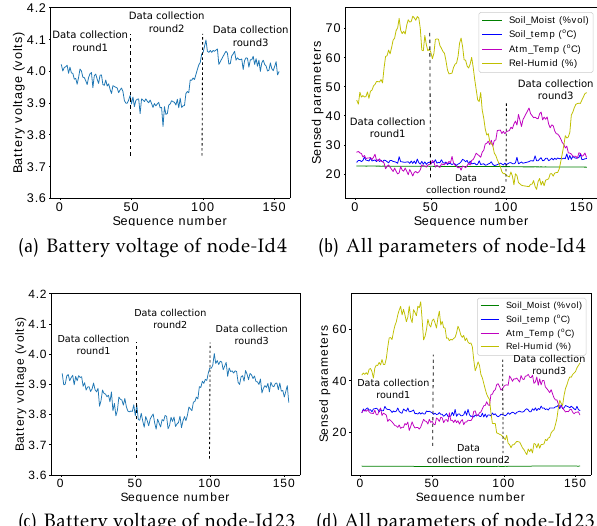
Figure 21. Sensed parameters - test case 1. Time interval between two consecutive sequence numbers in a datacollection timeslot is 10 minutes.